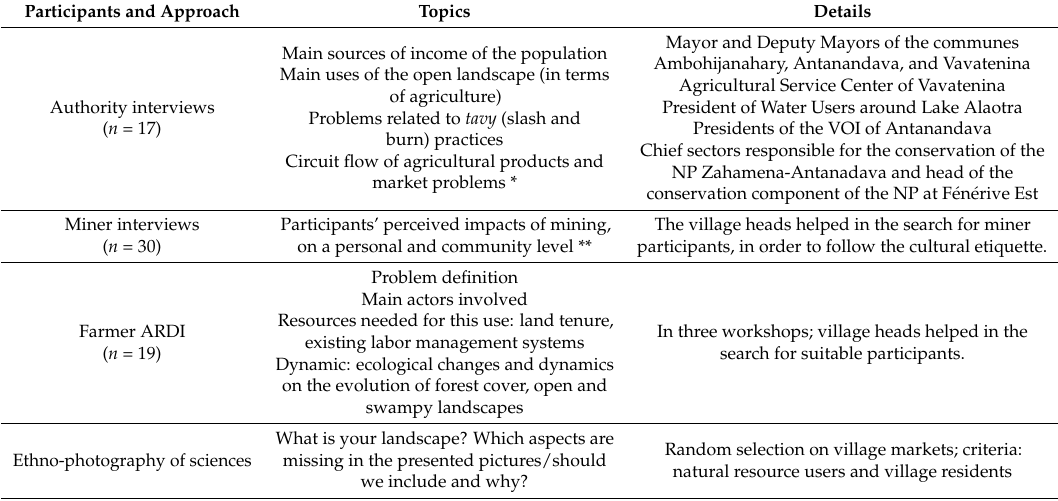
Table A3. Details on stakeholders and approaches that further complemented the above-described ones; VOI means vondron’olona ifotony, being an association of rural stakeholders involved in natural resource management; NP means National